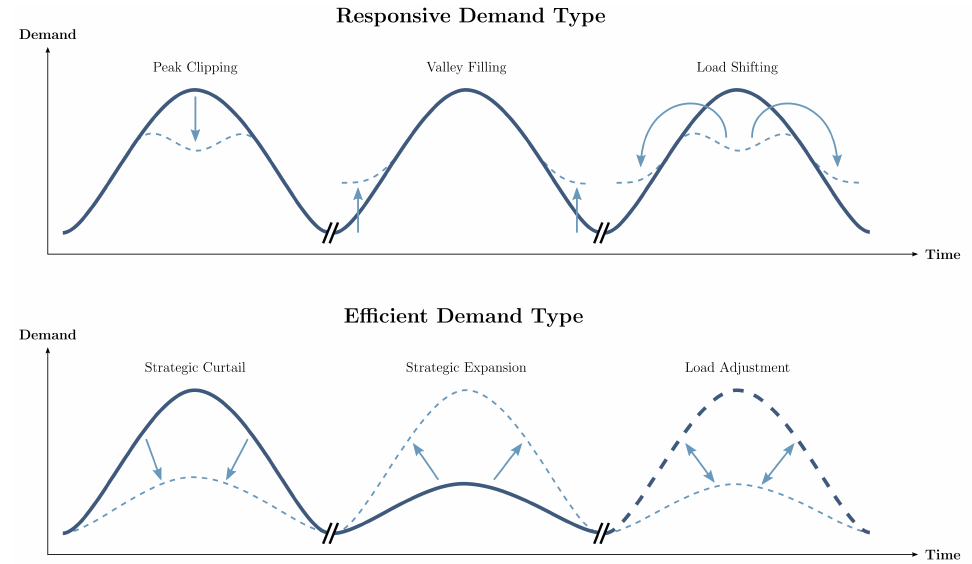
Figure 13. Demand Side Management techniques, both Responsive and Efficient Demand